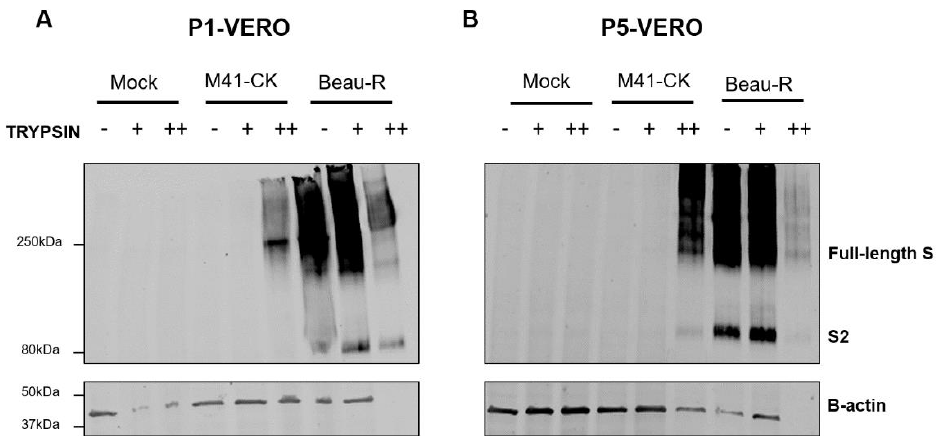
Figure 3. IBV spike (S) expression in the presence of trypsin. Cell lysates from mock, M41-CK infected and Beau-R infected Vero cells at P1 ( A ) and P5-Vero ( B ) were resolved by SDS-PAGE and analysed by Western blot. IBV S was detected using mAb 26.1 against the S2 subunit. Beta-actin was used as a loading control. Band sizes were compared with BioRad Dual Colour Standards. No change was observed in the size of the protein over the five passages. - indicates untreated/trypsin-free samples, + indicates samples propagated in BES medium containing 0.2 µg/mL TPCK-treated trypsin and ++ indicates samples propagated in BES medium containing 2 µg/mL TPCK-treated trypsin.